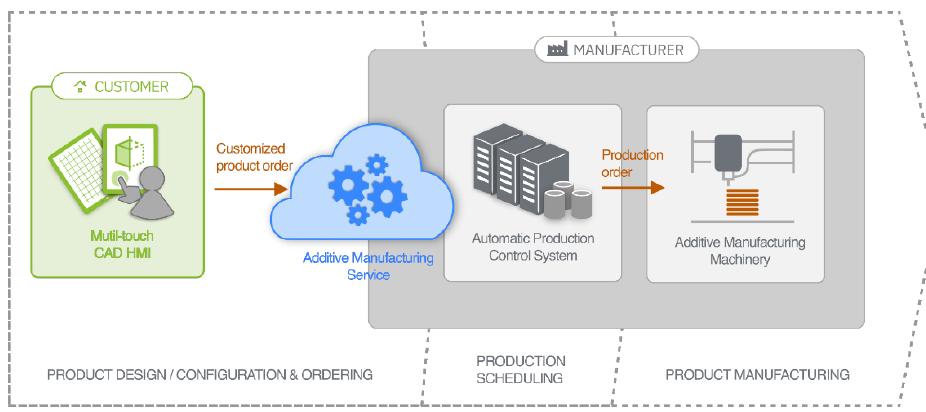
Figure 1. Realization of the customer-centric additive manufacturing vision based on the Multi-touch (computer-aided design human-machine interface) CAD HMI.